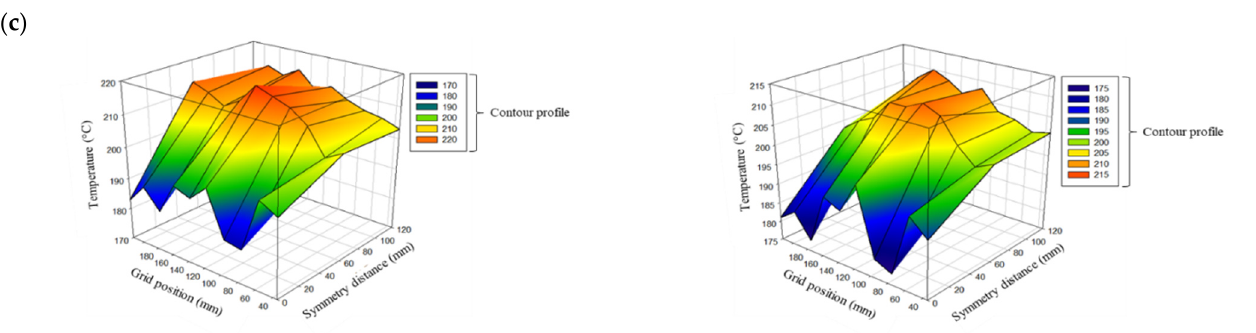
Figure 8. A heated air temperature profile during the reflow soldering process phase in the desktop reflow oven. ( a ) Measured at preheating phase (140 °C); ( b ) Measured at soaking phase (180 °C); ( c ) Measured at reflow phase (207 °C).